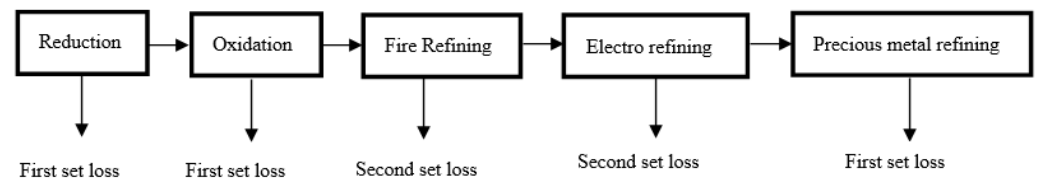
Figure 1. Exergy depletion through metal recycling out of electronic waste.